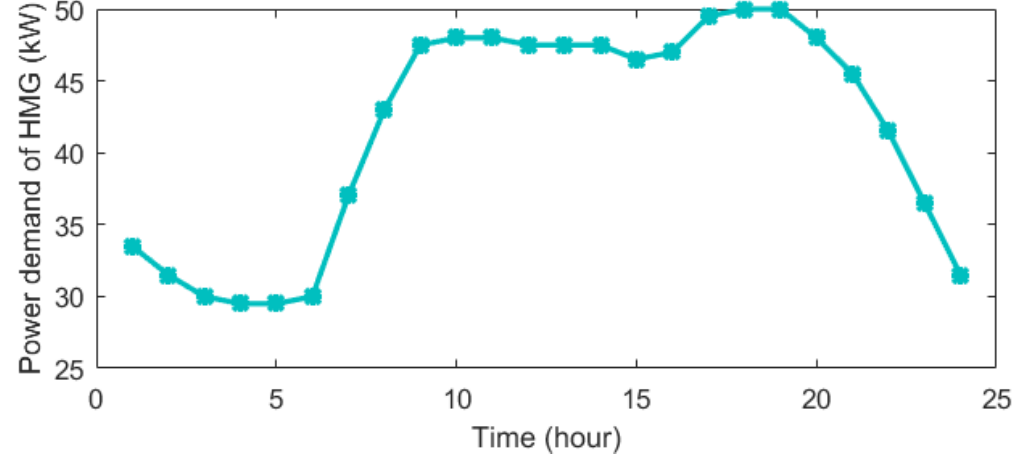
Figure 5. Profile of hybrid system demand during a day.